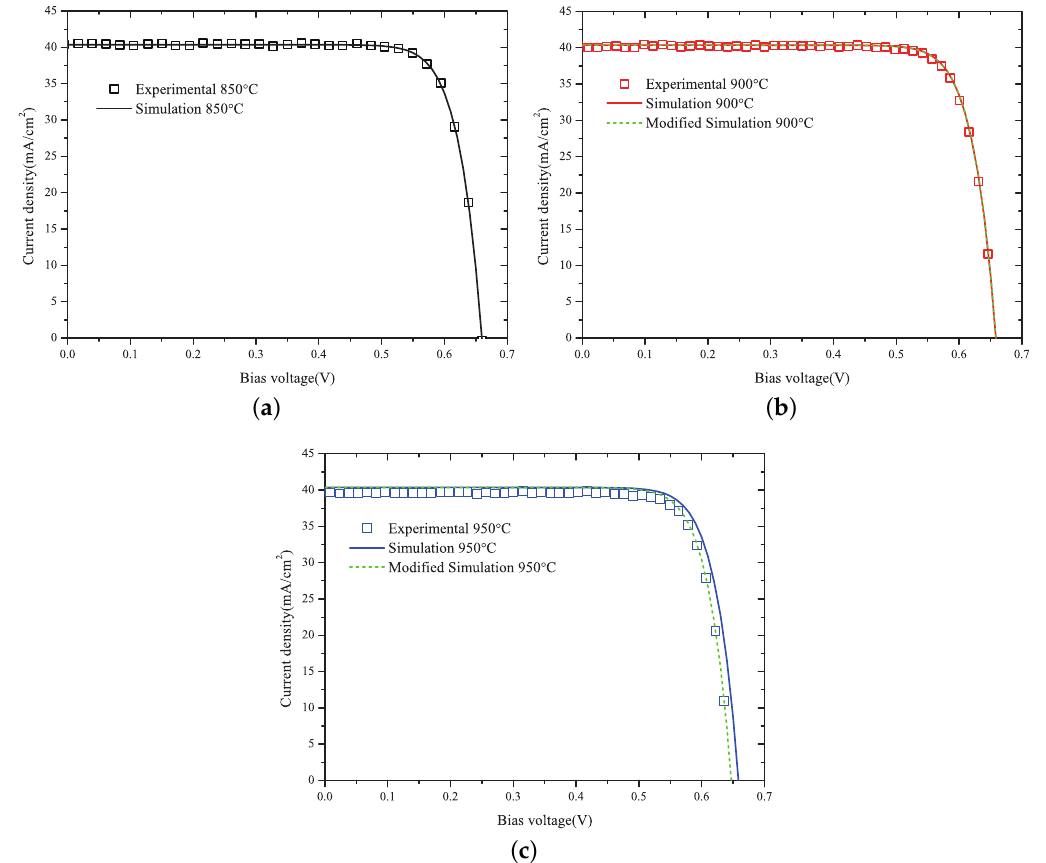
Figure 6. LIV data compared to numerical simulation results for the PERC solar cells. ( a ) Firing temperature 850 ◦ C, ( b ) firing temperature 900 ◦ C, ( c ) firing temperature 950 ◦